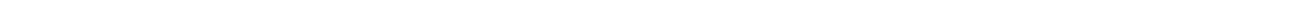
Fig. 2 DNA methylation and gene expression succeeds formation of A/B compartments. a Dynamic A/B status precedes with the formation of LMRs in A compartments and PMDs in B compartments during differentiation and maturation of CM. Depicted is a representative locus harboring the CM-speci fi c genes laminin subunit alpha 2 ( Lama2 ) and triadin ( Trdn ). b , c Analysis of selected compartments with A/B switch manifestation at the progenitor stage (upper panels). B compartments present at the progenitor stage gain PMDs and concordantly loose gene expression after exit from the multipotent stage b . Establishment of LMRs and induction of gene expression succeeds formation of A compartments c . d Genome-wide principle component analysis (PCA) of A/B compartment values results in a tight cluster of differentiated cardiac myocytes and distant pluripotent ES and multipotent progenitor cells (left graph). Performing PCA analysis of base-pair resolution CpG methylation data results in a trajectory of CM differentiation and maturation with the smallest distance between postnatal stages (right graph). e Averaging CpG methylation data for A and B compartment present at all assessed stages (Common-A, Common-B) reveals hypermethylation of B compartments as compared to A compartments in undifferentiated ES and progenitor cells, while differentiated CM show a hypomethylation in B vs. A compartments. Data shown are from n = 2 – 3 Hi-C, n = 1 – 3 RNA-seq and n = 2 – 3 WGBS experiments. Shown are mean ± SEM. FPKM fragments per kilobase per